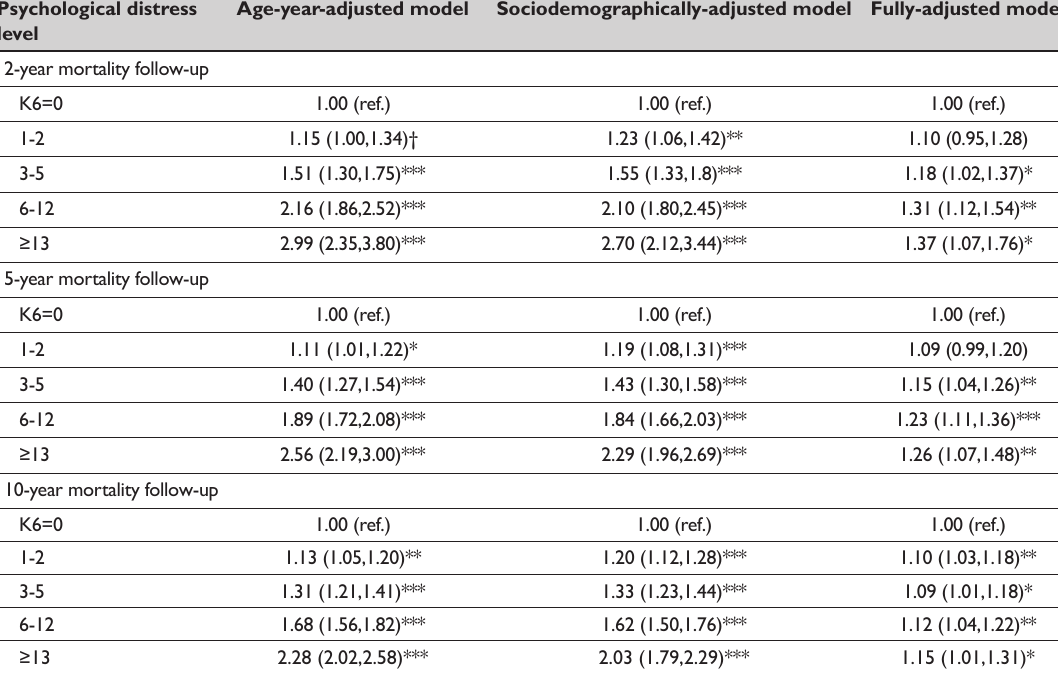
Table 6: Age-year-adjusted and covariate-adjusted hazard ratios (HRs) of heart disease mortality by psychological distress levels (K6) by different follow-up times among US adults aged ≥18